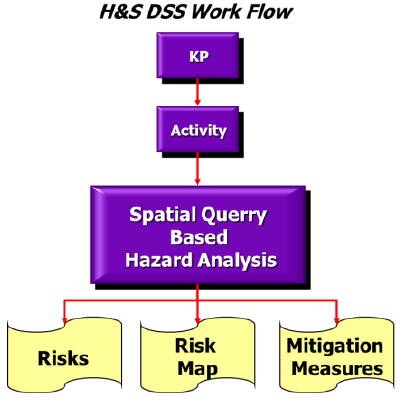
Figure7. H&S DSS Work Flow